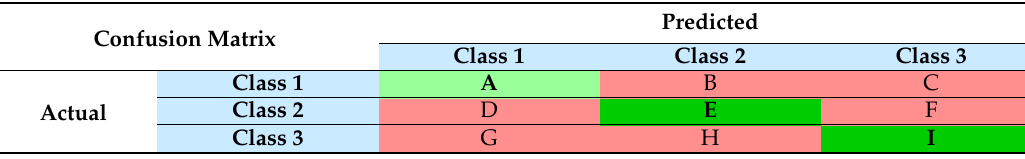
Table 6. Confusion matrix having 3